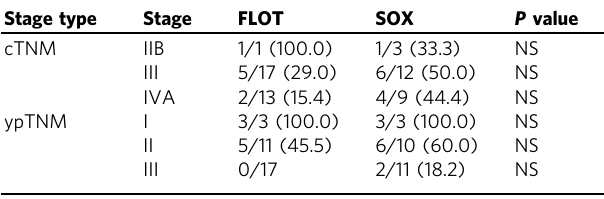
Table 7 Complete or subtotal tumor